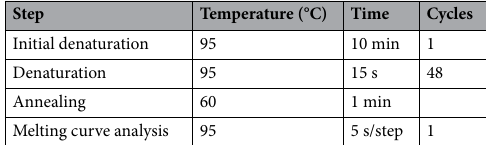
Table 2. Temperature, time, and the number of cycles for each